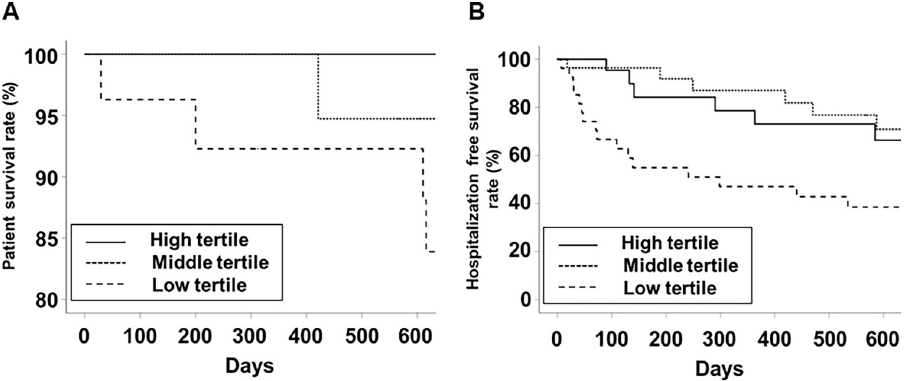
Fig 2. Kaplan-Meier curves for patient survival (A) and hospitalization-free survival (B).